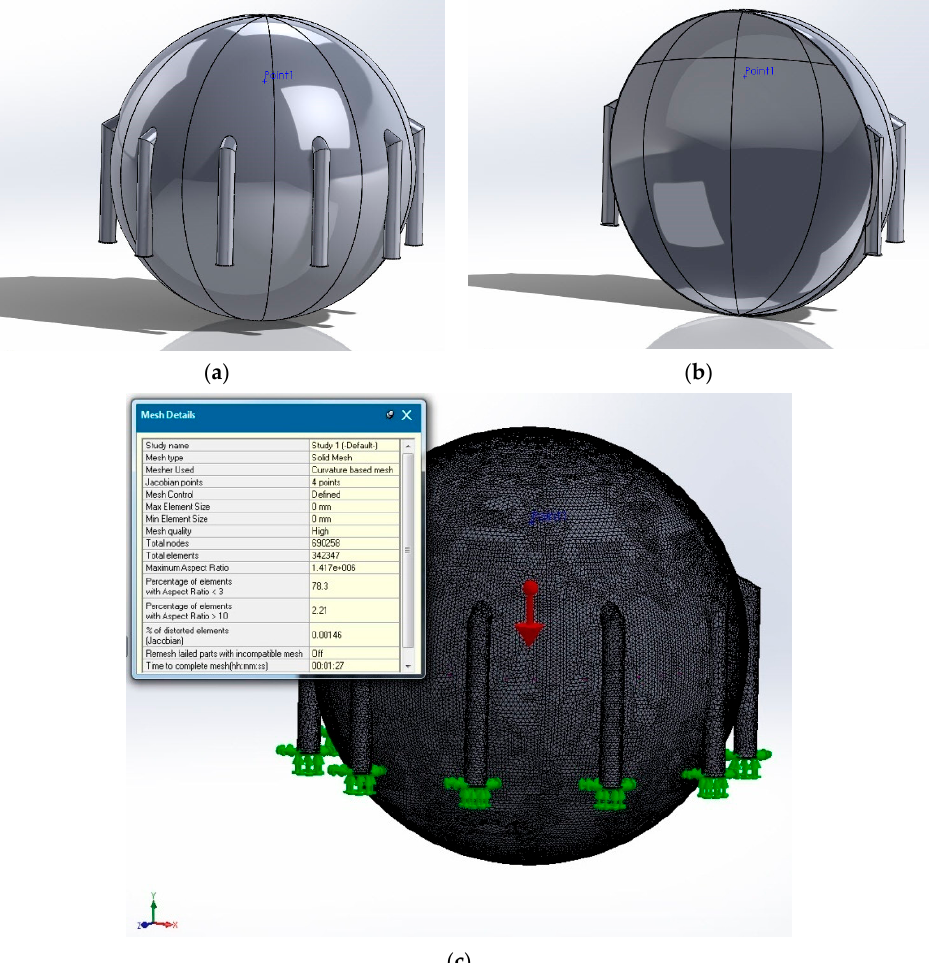
Figure 3. 3D modeling through an “assembly” set consisting of ten slice modules: ( a ) tank simulation model using the “assembly” option, ( b ) better 3D modeling quality with the absence of issues using the “assembly” option, and ( c ) mesh elements using a ten-slice modular assembly.